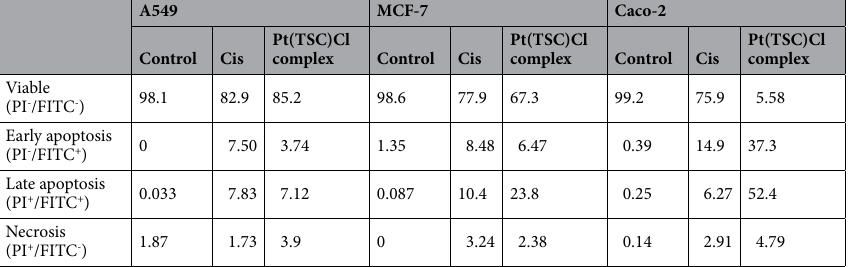
Table 7. Quantitative results of apoptotic effects of A549, MCF7 and Caco-2 cells, determined by Annexin V/FITC assay, for cells treated with IC 50 concentration of Cisplatin and Pt(TSC)Cl complex. Cells with no treatment considered as control group. *Cis: Cisplatin, A549: Human lung cancer cells, Caco-2: Human colon cancer cells, MCF-7 Human breast cancer